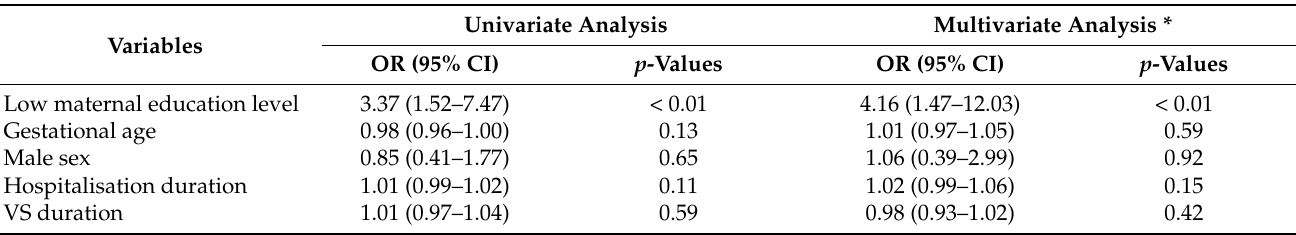
Table 6. Factors associated with incorrect classification with the Ages and Stages Questionnaire— Third